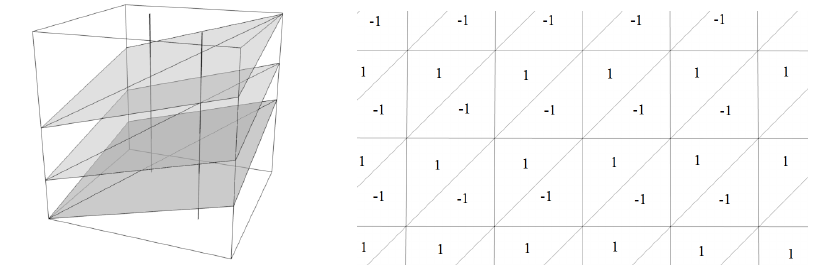
Figure 2. Minimal linear foliation on T 3 with a leafwise triangulation. Vertical segments represent, after quotient, the set of 1-barycenters B 1 . The bounded cochain given in Example 4 is represented in a generic